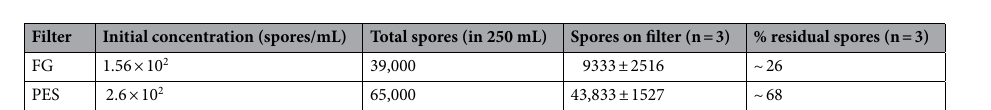
Table 2. Number of B. cereus spores remaining on FG and PES filters following the backwashing procedure.